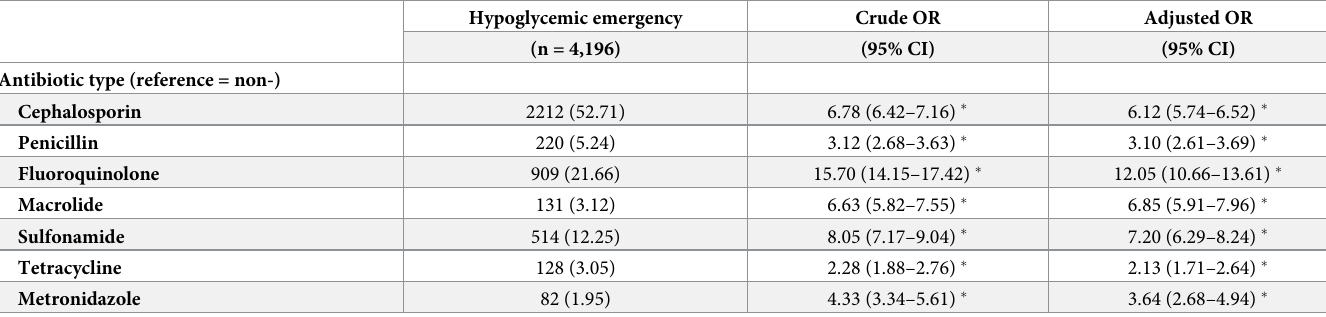
Table 2. Comparison of varied antibiotics (users Vs. non-users) as exposures towards the risk of developing hypoglycemia emergency